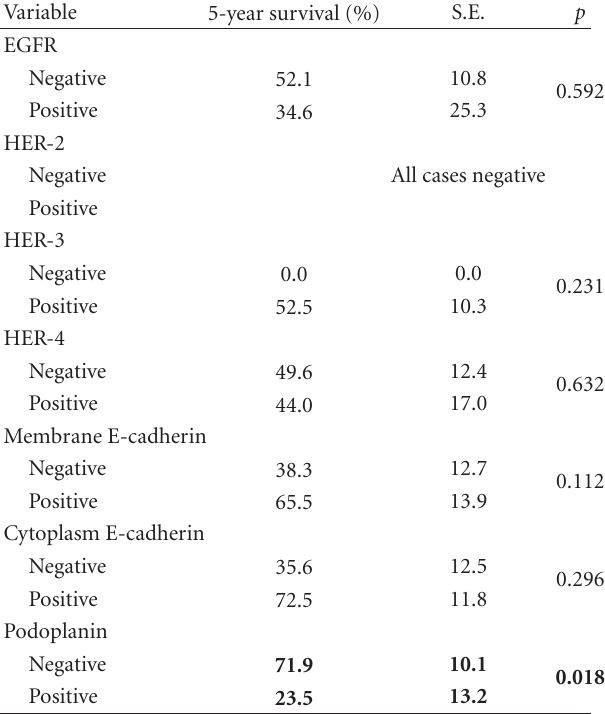
Table 4: Comparative specific cancer survival rates according to immunohistochemical primary tumor expression in patients with locally advanced cutaneous squamous cell carcinoma of trunk and extremities.